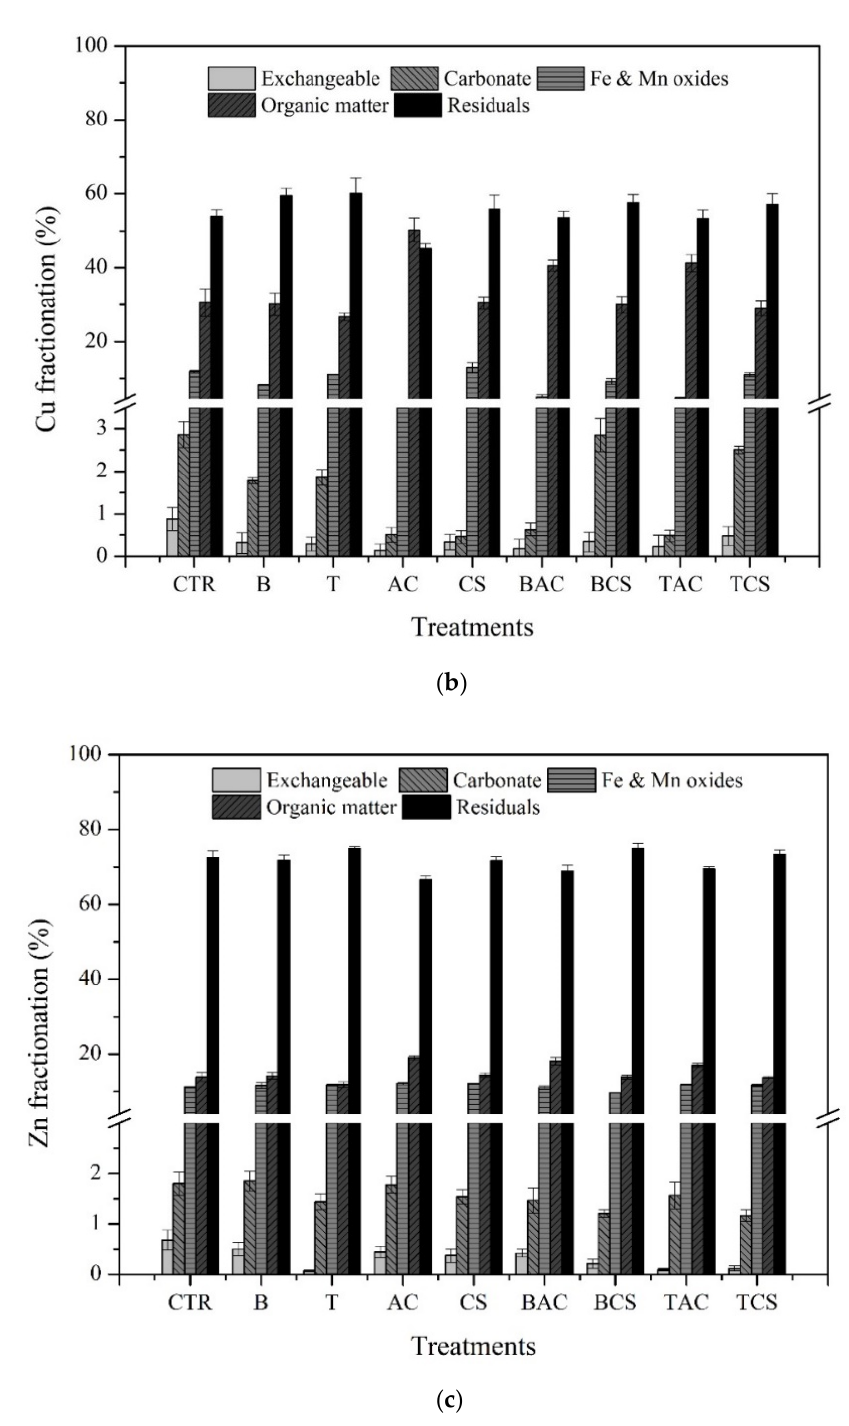
Figure 4. Arsenic, Cu, and Zn fractionation by sequential extraction of soil with different treatments after 45 days planting lettuce (Arsenic extracted by Wenzel et al., 2001, Cu and Zn extracted by Tessier et al. 1979, CTR: control, B: bentonite, AC: activated carbon, CS: cornstarch). Data are mean ± standard deviation (n = 3). ( a ) Arsenic fractionation, ( b ) Copper fractionation, ( c ) Zinc fractiona-